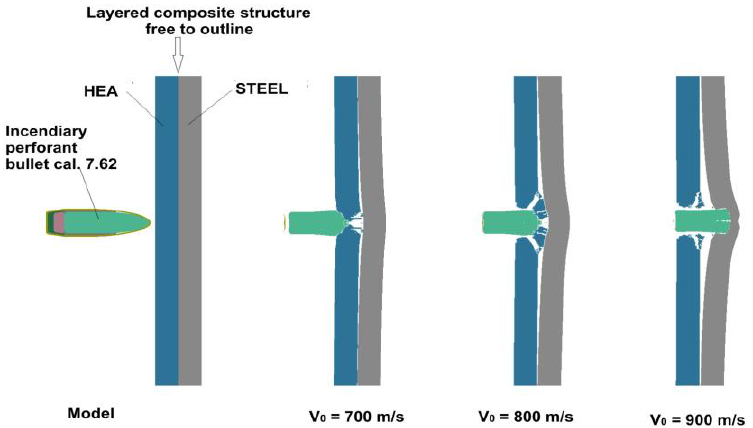
Figure 13. The behavior of the HEA-STEEL composite structure, welded to contour, at impact with an incendiary armor piercing bullet (7.62 mm caliber) with different initial speeds. Metals 2017 , 7 , 496